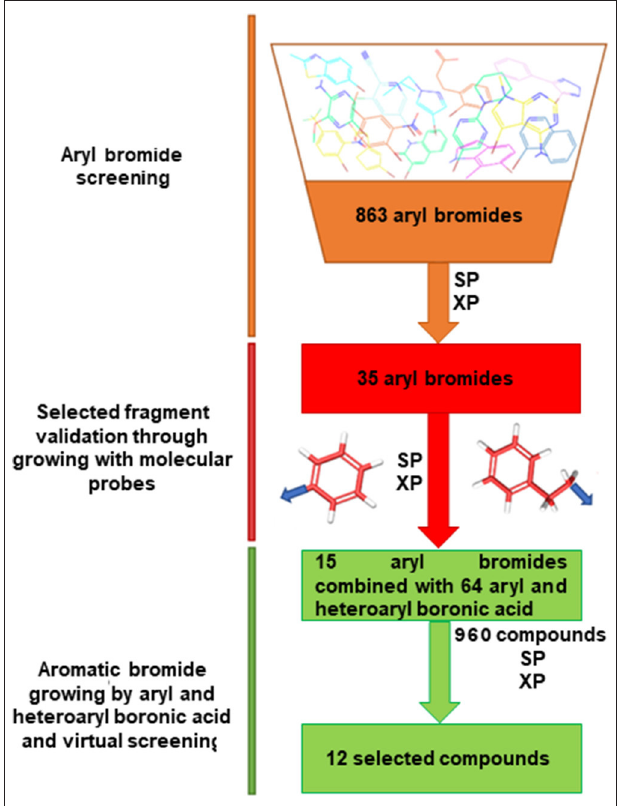
FIGURE 2 | Fragment-based approach